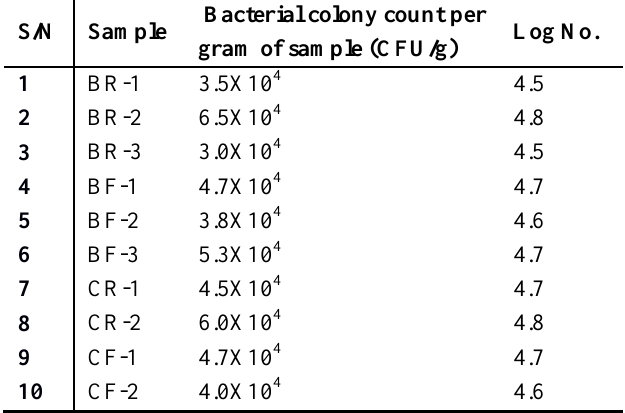
Table 1 . Total bacterial count of roasted and fried meats in beef and